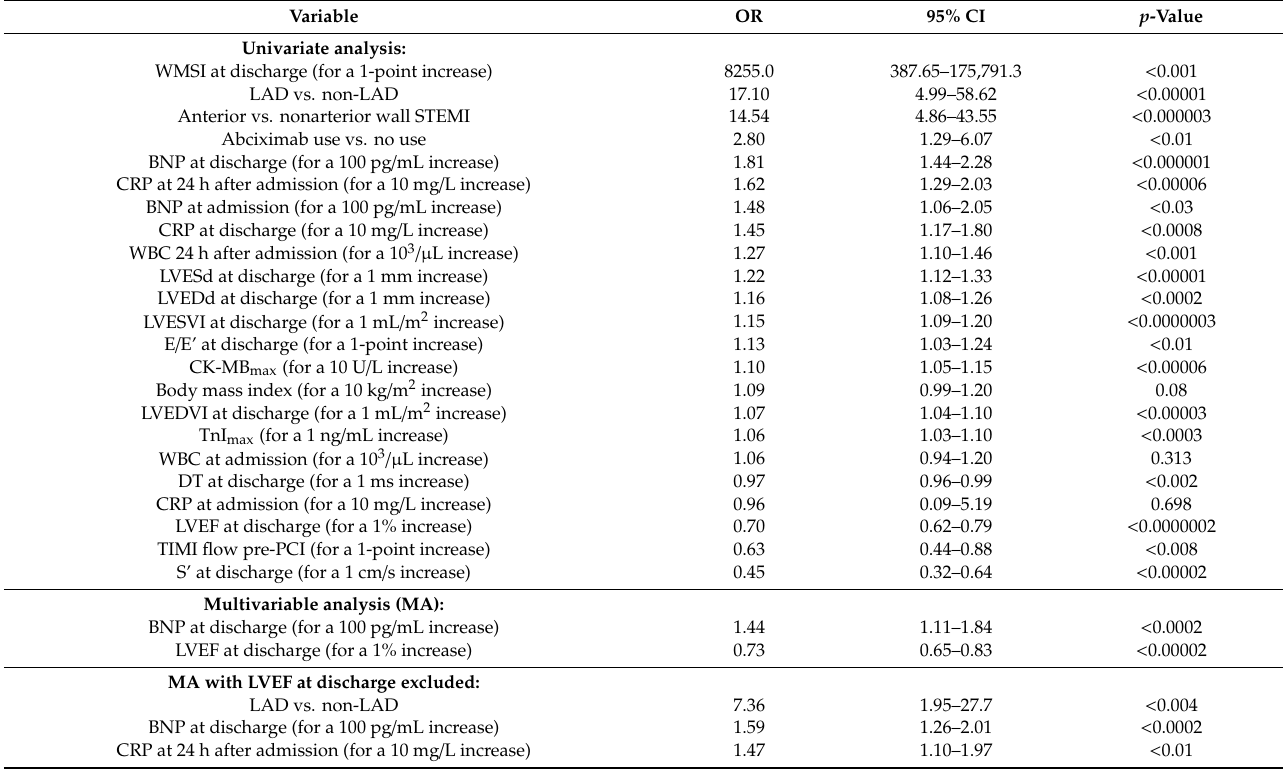
Table 4. Predictors of post-infarct left ventricular systolic dysfunction in a univariate and multivariable analysis. Variable OR 95% CI p -Value Univariate analysis: WMSI at discharge (for a 1-point increase) 8255.0 387.65–175,791.3 LAD vs.